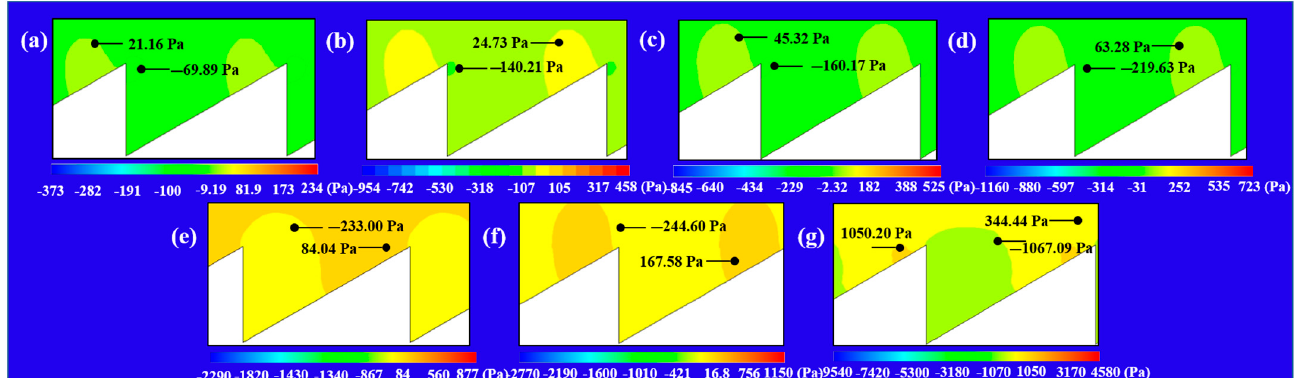
Figure 4. Pressure contour map of different flow velocity ( a ) 69.4 m/s, ( b ) 83.3 m/s, ( c ) 97.2 m/s, ( d ) 111.1 m/s, ( e ) 125 m/s, ( f ) 138.9 m/s, and ( g ) 250 m/s.